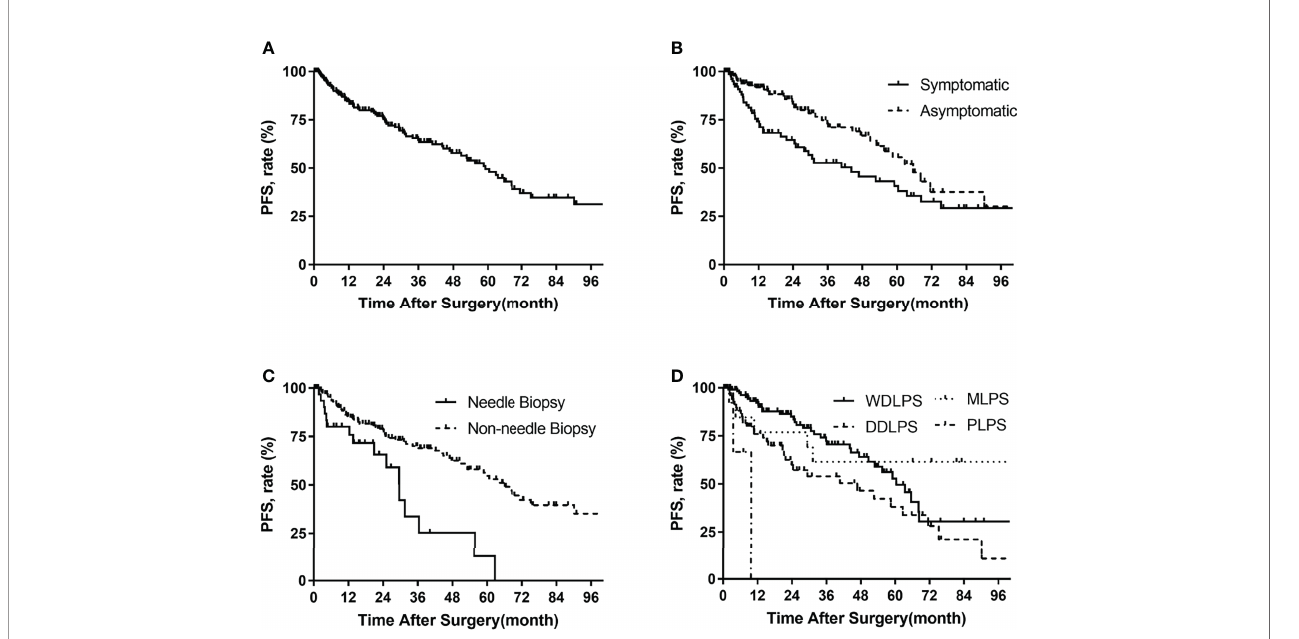
FIGURE 1 | Progression-free survival in patients with primary retroperitoneal liposarcoma by (A) all patients, (B) symptoms, (C) needle biopsy, (D) histologic subtypes.